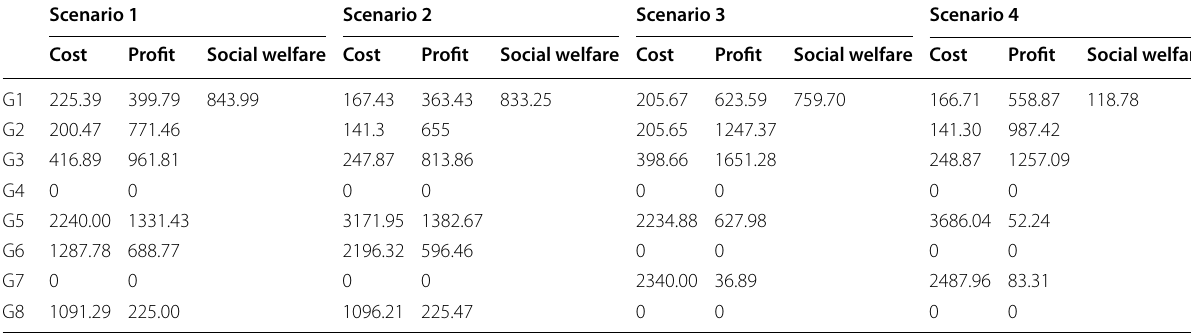
Table 2 Cost–benefit comparison (Million